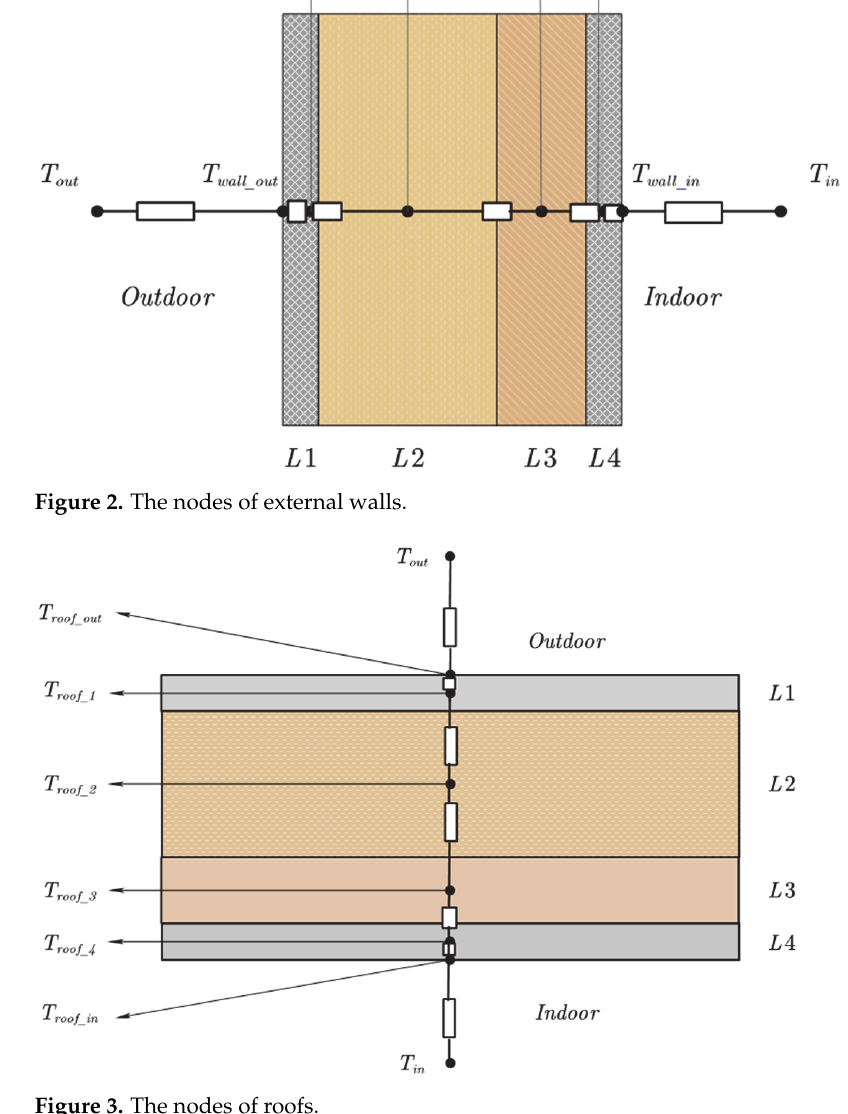
Figure 4. The nodes of floors. (1) Dynamic heat balance of external walls and roofs